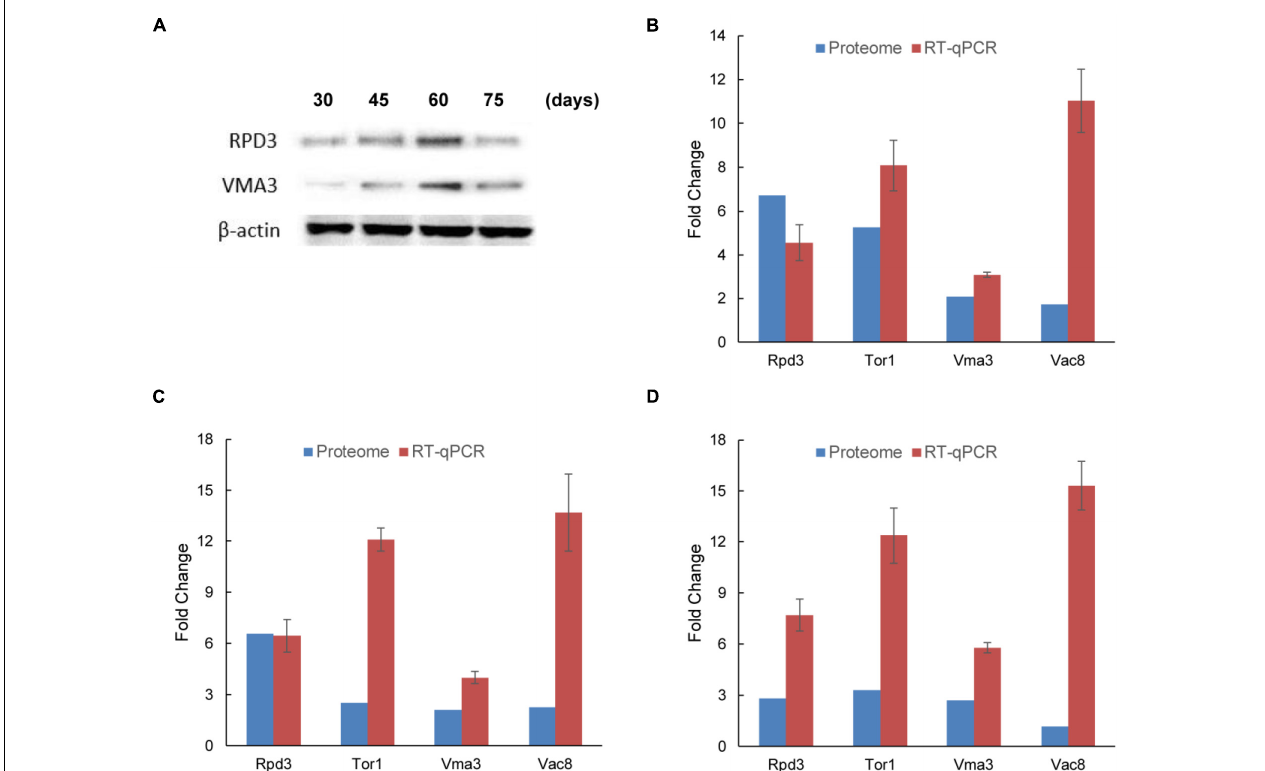
FIGURE 4 | Verification of accumulation patterns of iTRAQ identified proteins in brown film formation in Lentinula edodes . (A) Western blot analysis of two candidate proteins (RPD3 and VMA3) identified by iTRAQ. Lane 1, 30 days; lane 2, 45 days; lane 3, 60 days; and lane 4, 75 days. (B–D) Reverse-transcription qPCR analysis of the transcription levels of four differentially expressed proteins (RPD3, TOR1, VMA3, and VAC8). Comparisons: (B) 2-1, 45 days vs. 30 days; (C) 3-1, 60 days vs. 30 days; and (D) 4-1, 75 days vs. 30 days. Data represent the mean ± SD ( n =